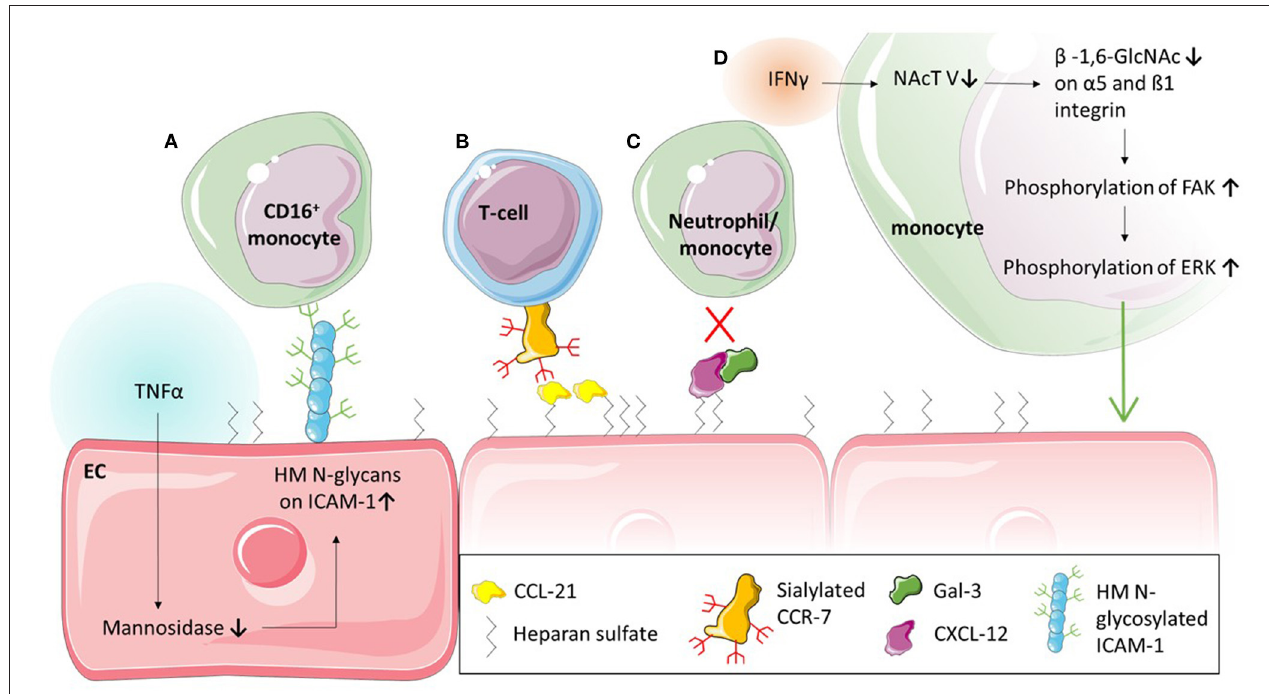
FIGURE 4 | Glycans and glycan binding proteins in leukocyte adhesion. (A) Tumour necrosis factor (TNF) α stimulation of endothelial cells (EC) leads to a decrease of mannosidases and in turn to an upregulation of high mannose (HM) ICAM-1 on the EC. This glycoform of ICAM-1 selectively causes the adhesion of CD16 + monocytes. (B) Chemokines such as CCL-21 are bound to the endothelial surface via glycosaminoglycan heparan sulfate and interact with sialylated CCR-7 to mediate T-cell adhesion. (C) Glycan binding protein Galectin (Gal)-3 forms heterodimers with CXCL-12 which inhibit adhesion of neutrophils and monocytes in vivo . (D) Interferon (IFN) γ stimulation of monocytes reduces N-acetylglucosaminyltransferase (NAcT) V, which in turn decreases glycosylation of α 5 and β 1 integrin. This increases the phosphorylation of Focal adhesion kinase (FAK) and consequently Extracellular signal-regulated kinase (ERK), resulting in increased adhesion of monocytes.